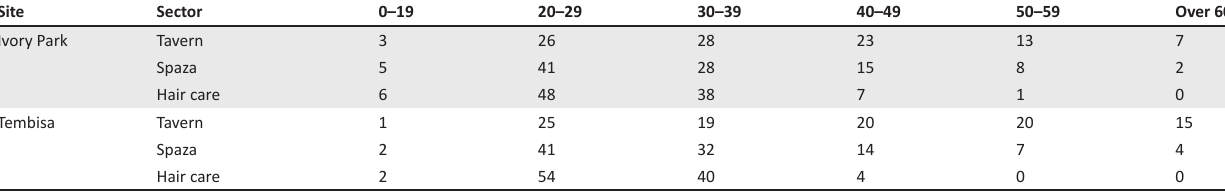
TABLE 5: Business ownership and/or age ( % of enterprise